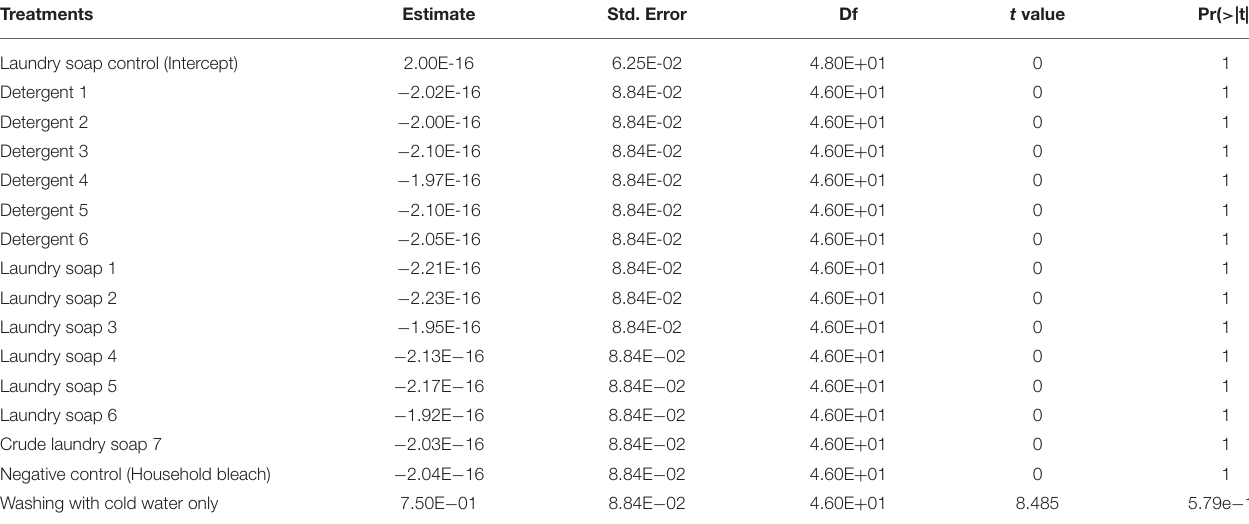
TABLE 4 | Fixed effects of different laundry soaps and detergents obtained from within Kampala, Uganda on the incidence of farm tools with Xanthomonas vasicola pv. musacearum . Treatments Estimate